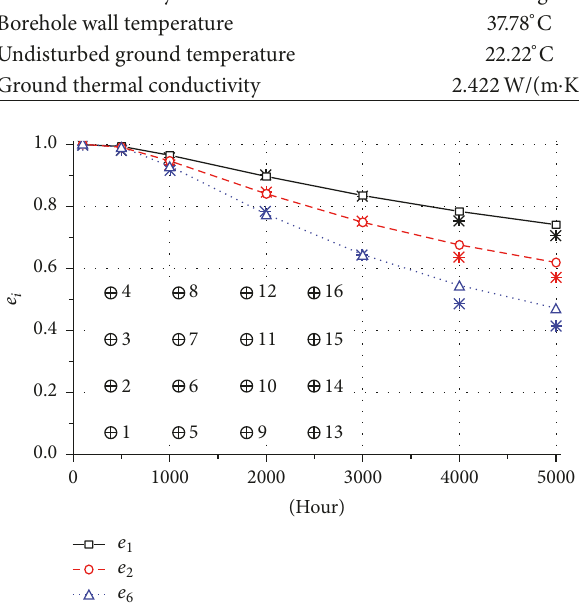
Figure 2: Comparison results of thermal effectiveness for a 4 × 4 borehole field [19].